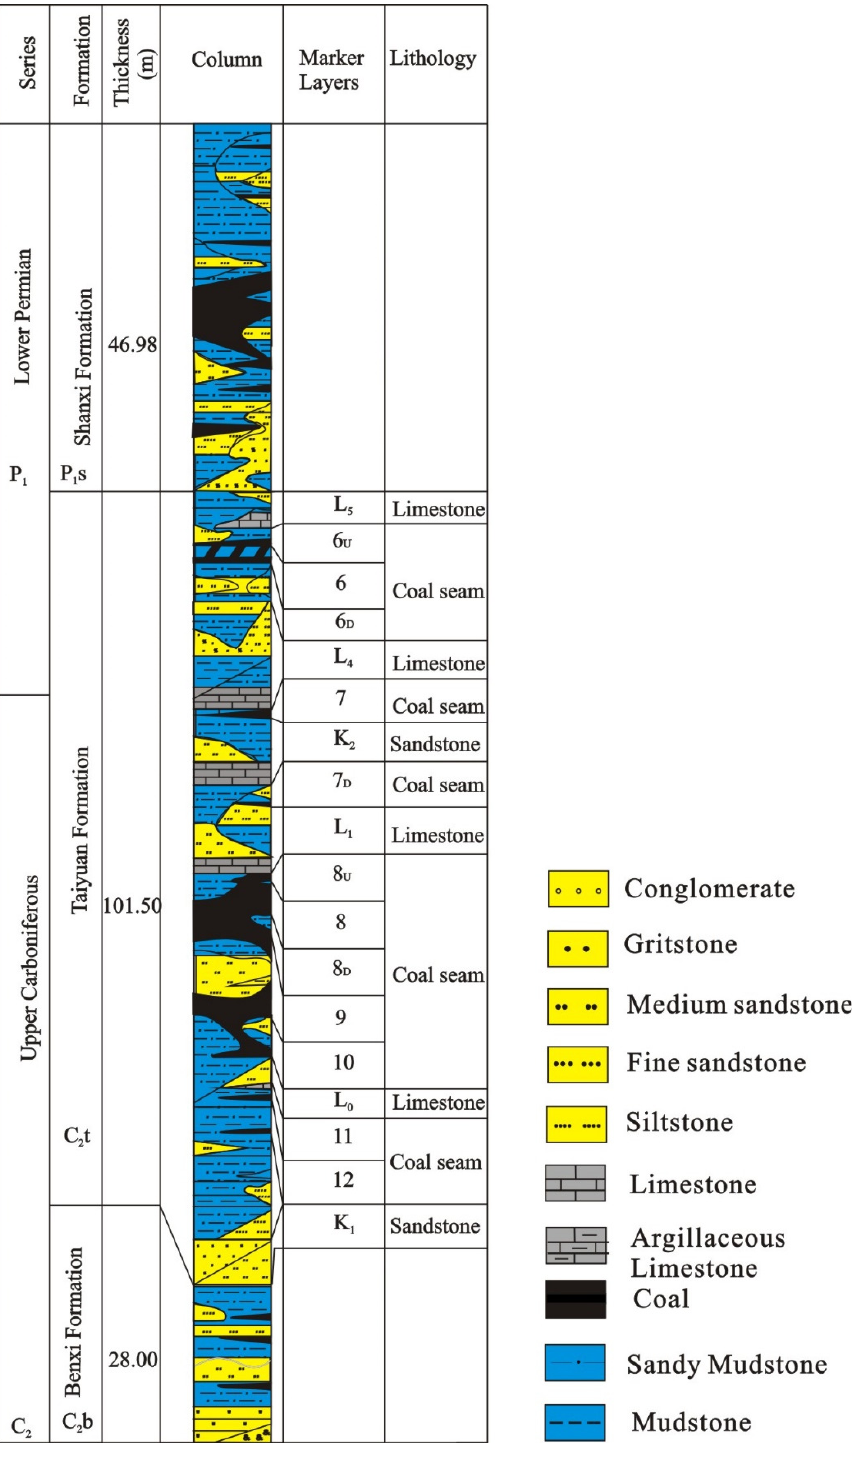
Figure 2. Comprehensive histogram of coal-bearing strata.